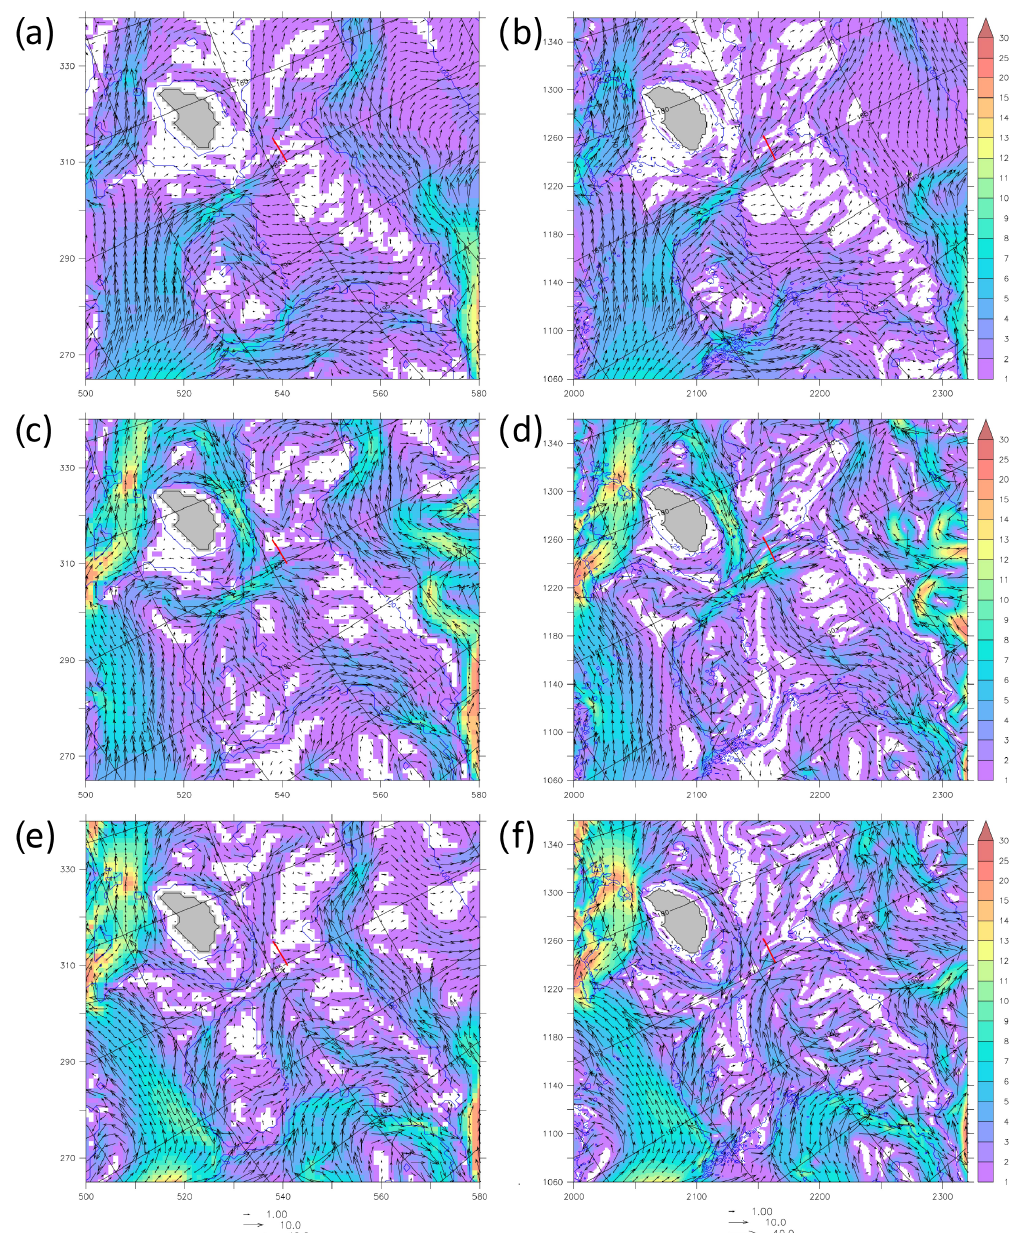
Figure 8. Upper 100m averaged speed (shading) and velocity vectors (cms − 1 ) from model output. The left column (a, c, e) is from the 9km model results and the right column (b, d, f) is from the 2km model results. The top row (a, b) is a 10-year mean from 2006–2015. The middle row (c, d) is a mean for September 2008. The bottom row (e, f) is a mean for August 2014. Every second vector for 9km and every eighth vector for 2km is shown. Blue lines indicate isobaths at 25, 50, 100, and 1000m. The red line indicates the location of section 3 discussed elsewhere. The x and y axes are labelled with model grid cell